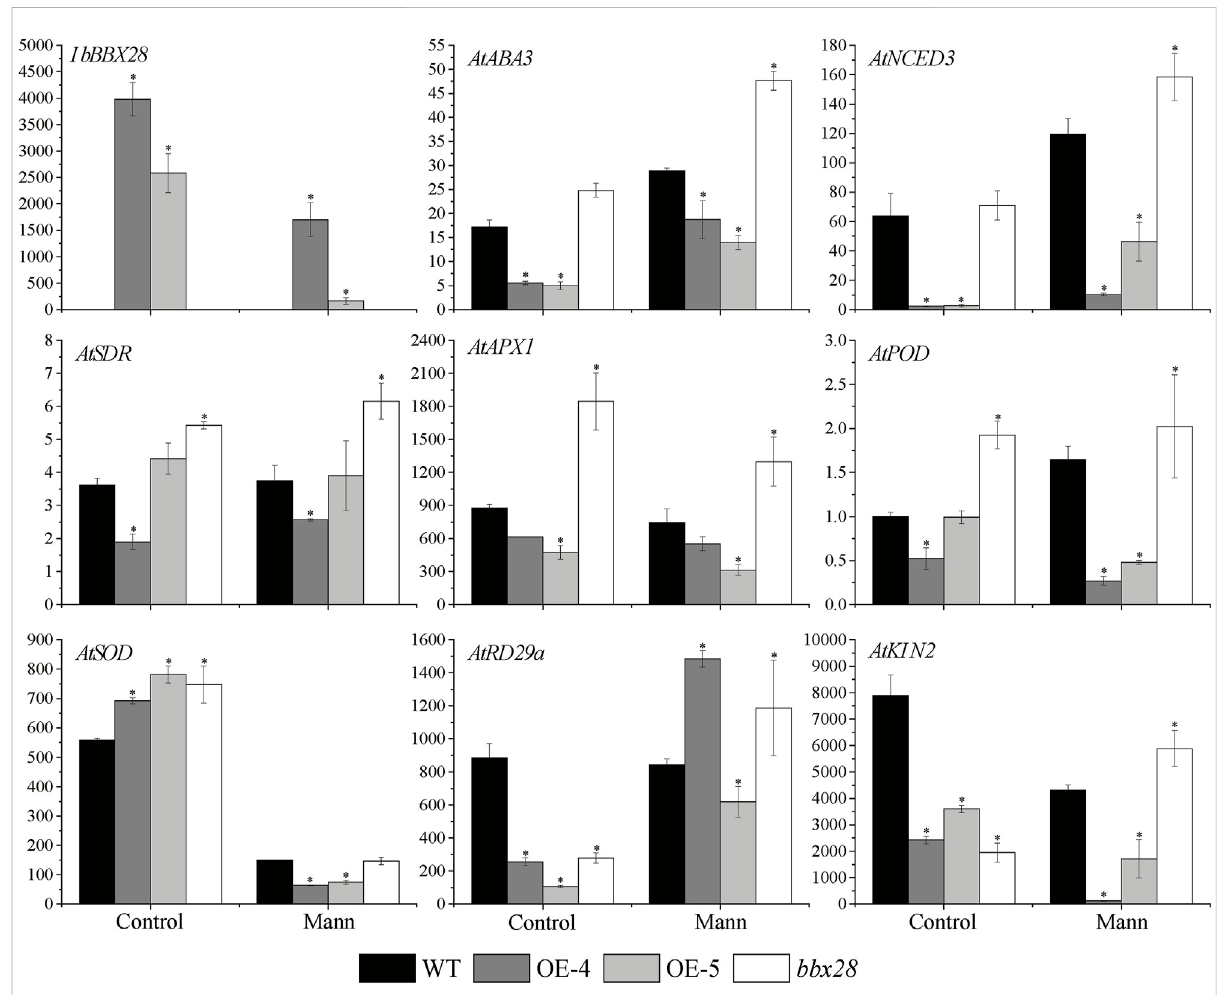
FIGURE 6 Expression analysis of overexpressing IbBBX28 transgenic Arabidopsis resistance related genes under drought stress. The expression of AtPOD inWTincontrolgroupwassetas1-fold.Dataarepresentedasmeans±SD( n =3).*indicatesasigni fi cantdifferenceofOE-4,OE-5,and bbx28 from that of the WT at p < 0.05 by the t -test.